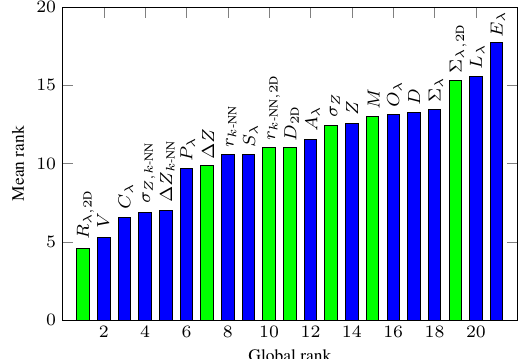
Figure 1: Mean rank of the derived 3D features (blue) and those features derived from considerations in 2D